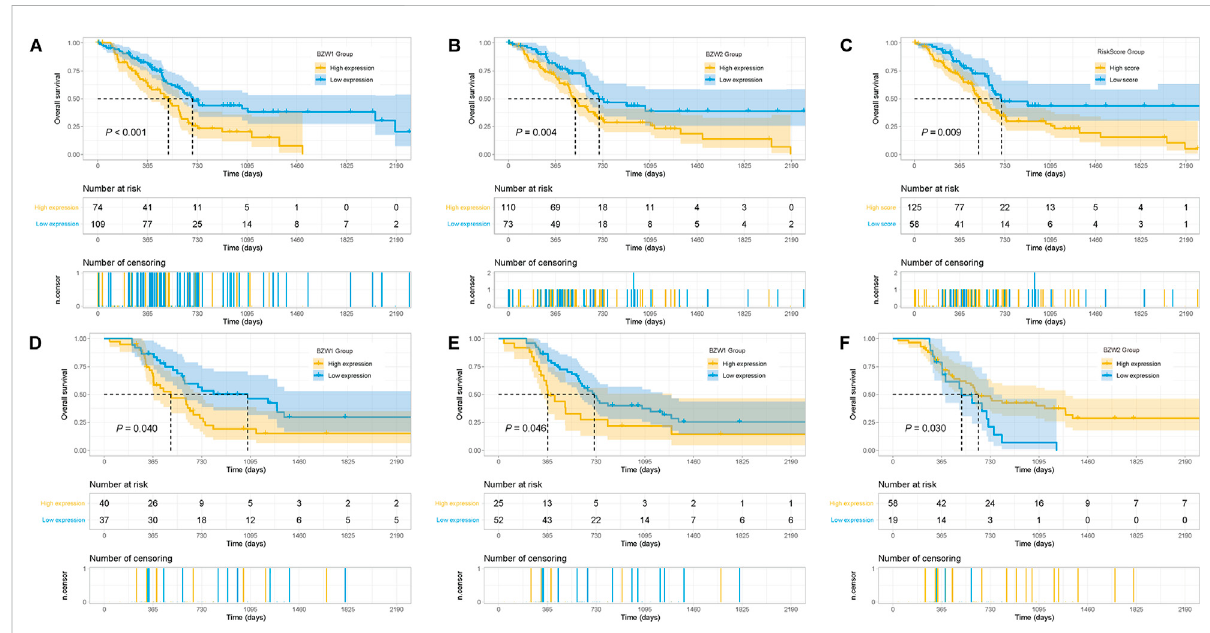
FIGURE 4 Kaplan-Meier survival curves of different BZW1 and BZW2 expression for TCGA-PAAD patients (A,B) . Survival curve of low- and high-RiskScore group for TCGA-PAAD patients (C) . Survival curves indicated that patients with high expression of BZW1 (11757867_s_at and 11744775_x_at) and BZW2 (11747677_a_at) suffered poor prognosis in GSE85916 cohort (D) : 11757867_s_at, (E) 11744775_x_at and (F)